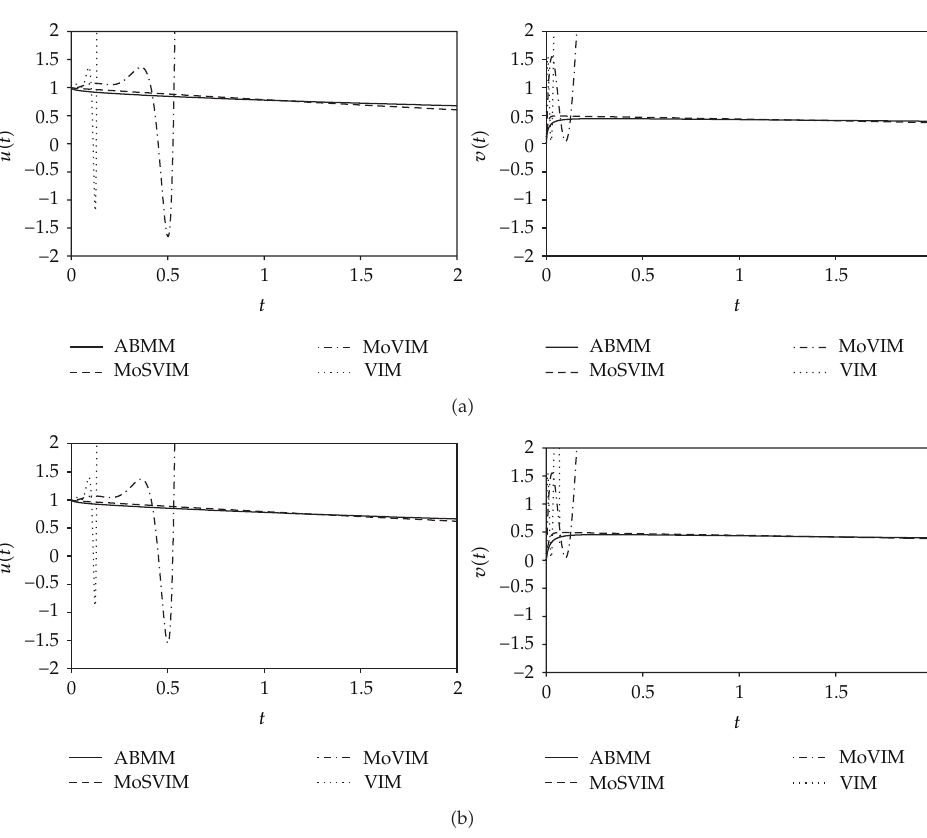
(cid:9) 0 . 25 using fifth (cid:0)